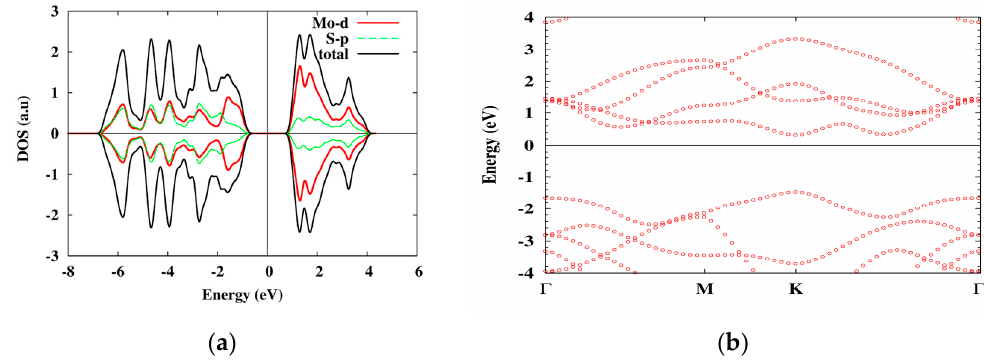
Figure 4. The orbital DOS ( a ) and the band structure ( b ) of 1 L MoS 2 obtained with PBE approximation. The electronic band gap is 1.8 eV.